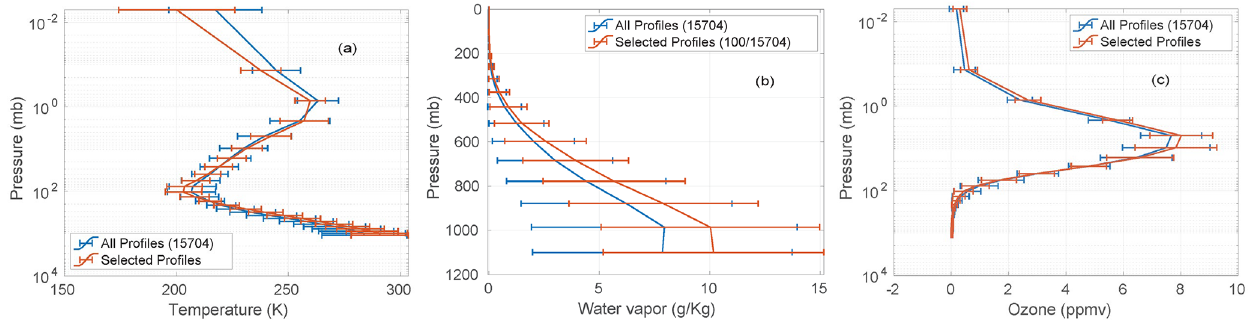
Figure 4. Profile statistics of (a) temperature, (b) water vapor, and (c) ozone for the entire available sample and for the reduced sample used in this study. The error bar is 1 standard deviation.